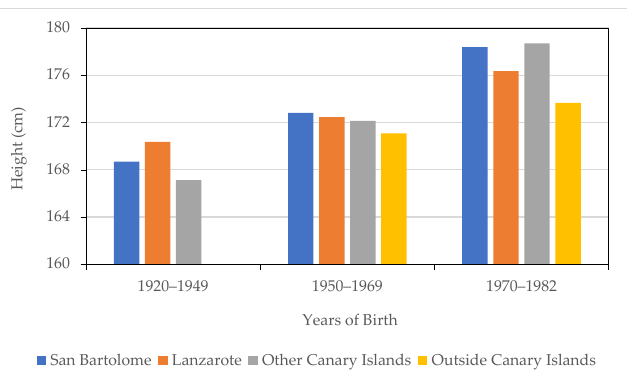
Figure 13. Average height by origin and year of birth. Source: AMSB, ACDS. Own work.